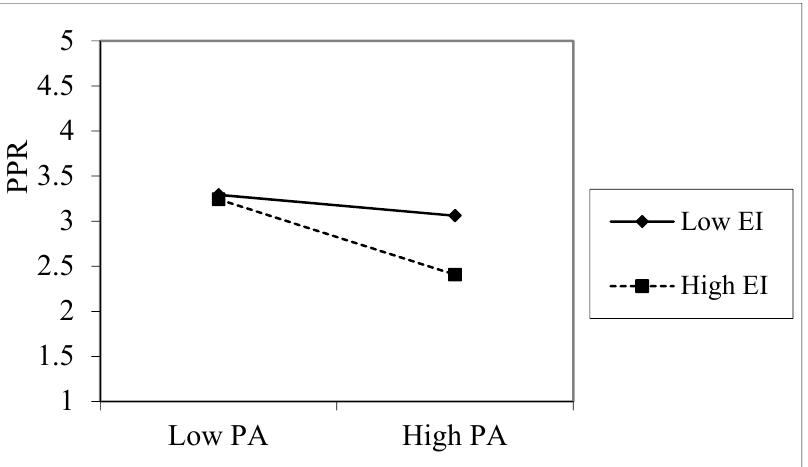
Figure 3. The interaction effect of peer attachment with emotional intelligence on perceived personal rejection. PA = peer attachment, PPR = perceived personal rejection, EI = emotional intelligence, PIU = pathological Internet use.